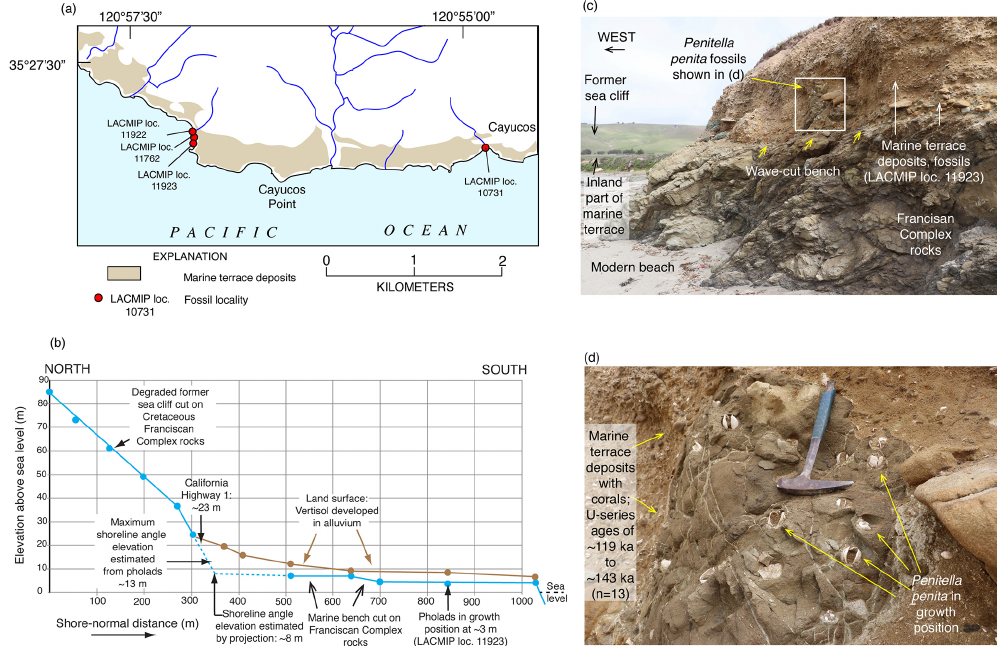
Figure 6. Two methods of estimating paleo-sea level when shoreline angles are not exposed at Cayucos, California. (a) Map showing extent of marine terrace dated to ∼ 120ka and fossil localities from Muhs et al. (2002a). (b) Topographic profile of a shore-normal transect in the vicinity of fossil localities LACMIP (Natural History Museum of Los Angeles County Invertebrate Paleontology) 11923, 11762, and 11922, showing measured bench elevations and paleo-sea cliff elevations, where they are exposed; intersection of extrapolated wave-cut bench slope landward and paleo-sea cliff slope downward yields an estimated shoreline angle elevation of ∼ 8m. (c) Photograph of outer edge of terrace at fossil locality LACMIP 11923, showing wave-cut bench 3m above sea level with Penitella penita fossils (rock-boring bivalves) in growth position (see enlargement in d ). P. penita lives in waters 10m deep or shallower, so bench elevation (3m) plus maximum depth of growth (10m) yields a maximum-limiting paleo-sea level of ∼ 13m above present. Photographs by Daniel R. Muhs. Table 2. Measurement techniques used to establish the elevation of MIS 5e shorelines on the Pacific coast of North America. Measurement technique Description Typical accuracy Hand level and tape Hand level and meter tape On the order of tens of centimeters and/or use of transit and stadia Aneroid altimeter American Paulin System On the order of 0.5m aneroid altimeter Global Positioning System (GPS) Uses satellite array and triangu- On the order of tens of centimeters if lation with post-processing to satellite geometry is increase accuracy